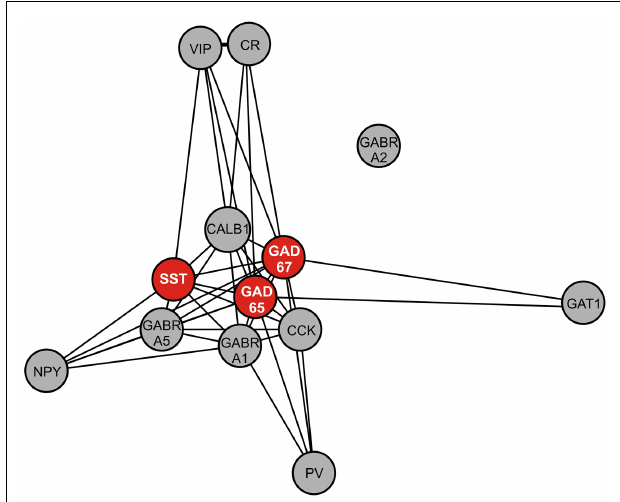
FIGURE 4 |Weighted gene co-expression network of GABA-signaling-related genes . Genes included in this network are GABA interneuron markers [somatostatin (SST), parvalbumin (PV), neuropeptideY (NPY), calretinin (CR), calbindin (CALB1), vasoactive intestinal peptide (VIP), cholecystokinin (CCK)], GABA A receptor subunits (alpha 1 (GABRA1), alpha 2 (GABRA2), alpha 5 (GABRA5), and GABA-related genes [GAD67, GAD65, GABA transporter 1 (GAT1)]. Nearness of nodes is proportional to co-expression strength. Along with SST, GAD67, and GAD65, genes in the core module include CALB1, which is often co-localized with SST, and GABRA5, which is postsynaptic to SST-positive GABA neurons.